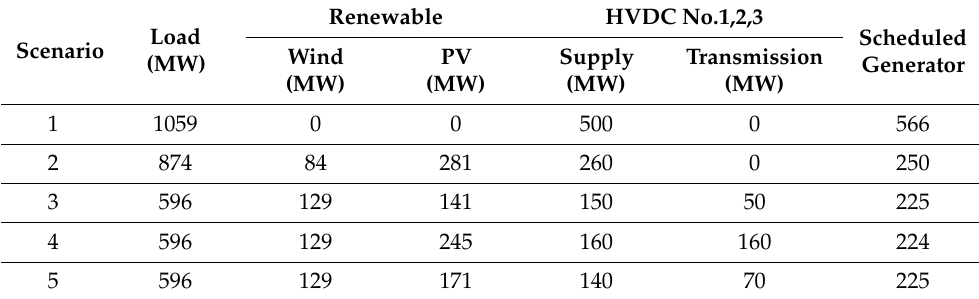
Table 4. Scenario B configuration (HVDC No.3 supply).